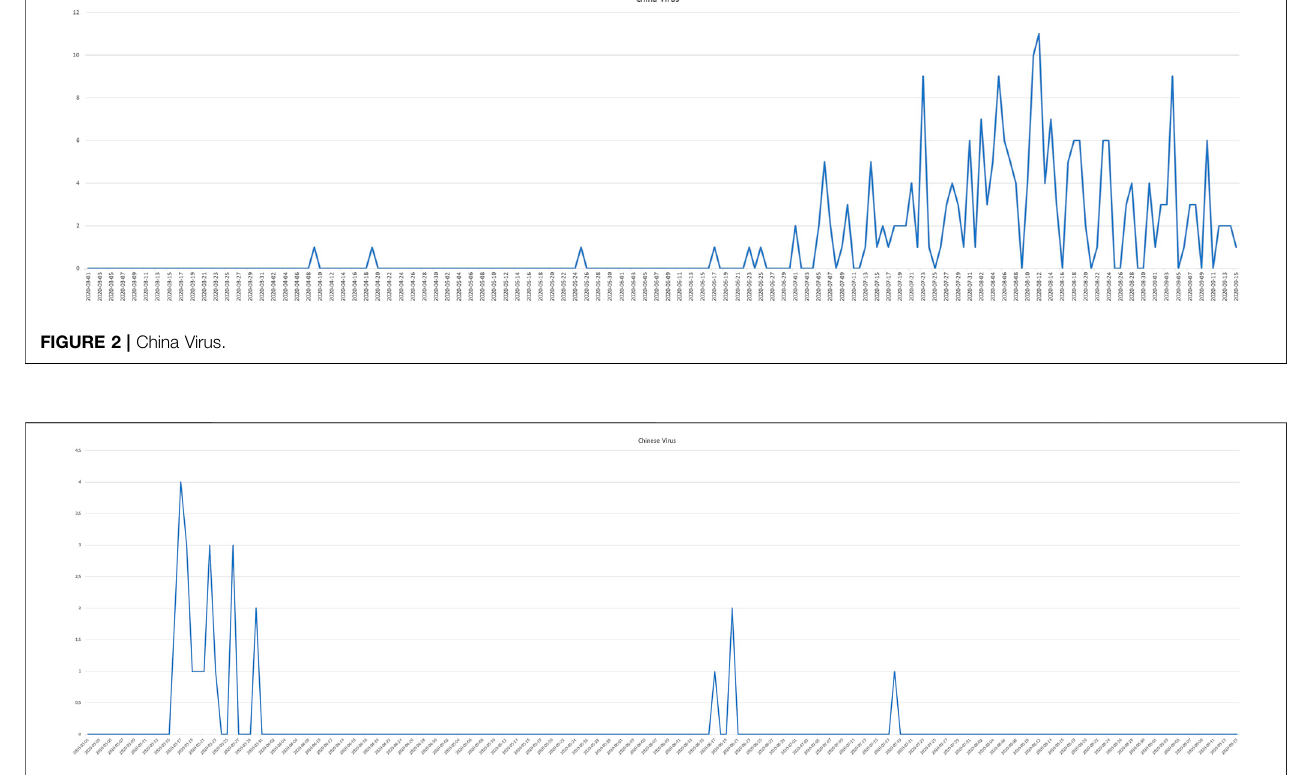
FIGURE 3 | Chinese